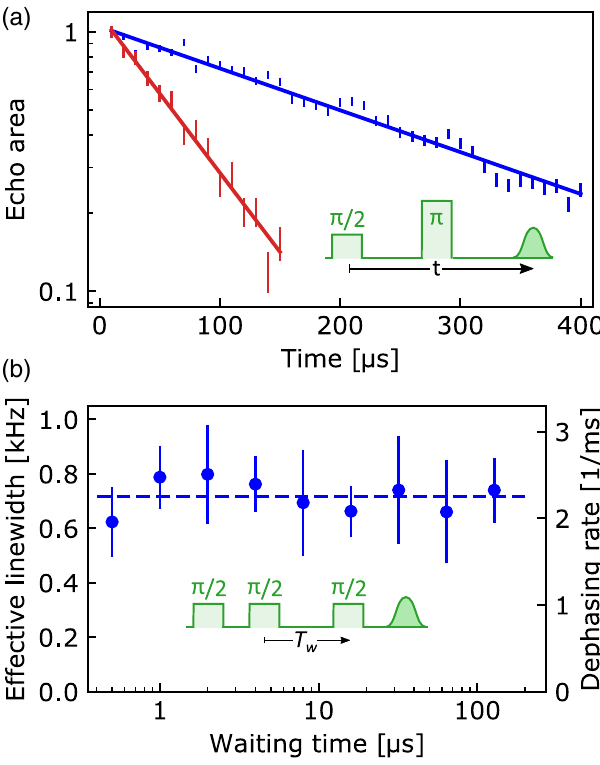
FIG. 3. Optical coherence measurement. (a) Two-pulse photon echo. The used sequence, with 0 . 5 μ s long optical π pulses with a power of 54 nW, is shown in the inset. As expected in the absence of spectral diffusion during the optical lifetime, the coherence decays exponentially with the echo time t . Compared to the situation without photothermal feedback (blue), a faster decay is observed when the resonator frequency is stabilized (red), which we attribute to heating of the crystal. (b) Three-pulse photon echo. We measure the echo after three π = 2 pulses, as shown in the inset. We observe a constant effective linewidth Γ independent eff of the waiting time T w , which further testifies to the absence of spectral diffusion within the 0.19(2) ms Purcell-enhanced lifetime of the strongest-coupled